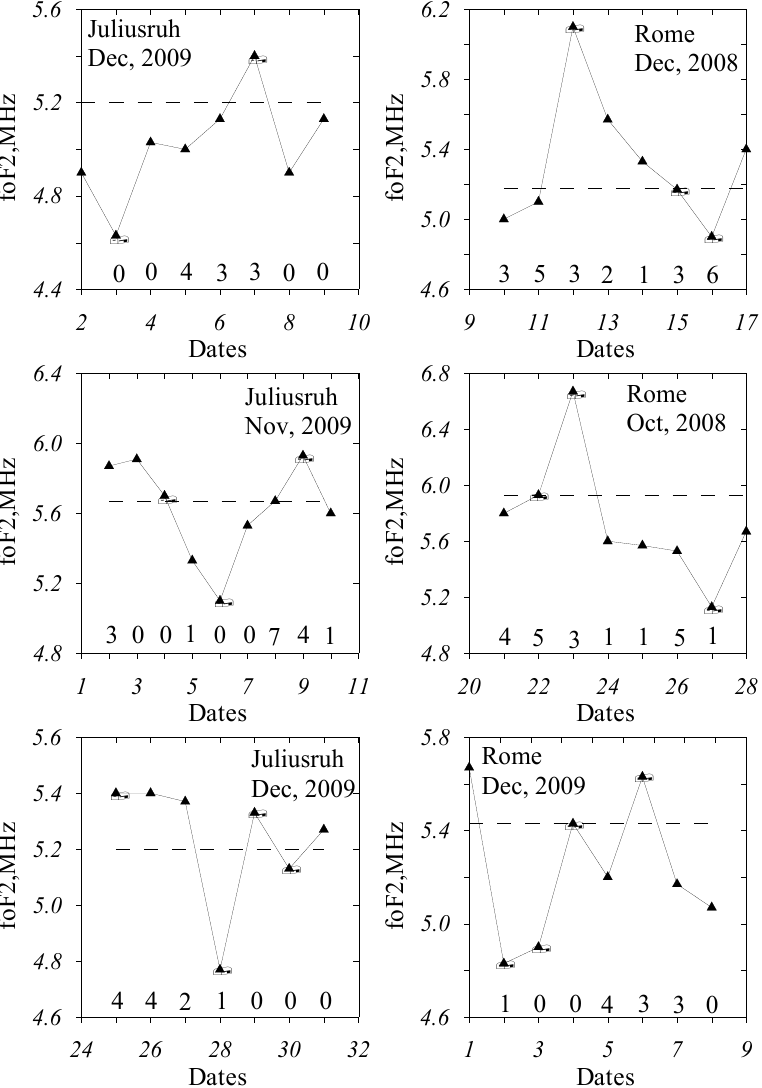
Figure 1. Selected F 2 -layer Q-disturbances of the ‘meteorological’ origin. Monthly median f o F 2 are given with dashed lines. Circles—dates analyzed for the aeronomic parameters. Numbers at the bottom of panels—daily Ap